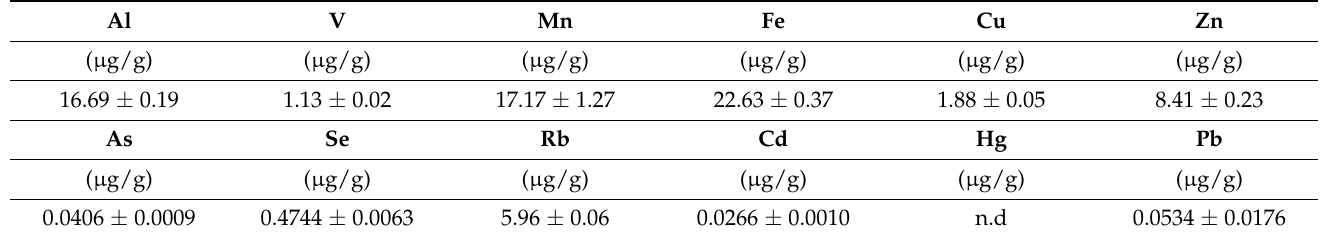
Table 2. Results obtained for selected elements reported as mean values ± SD, n =